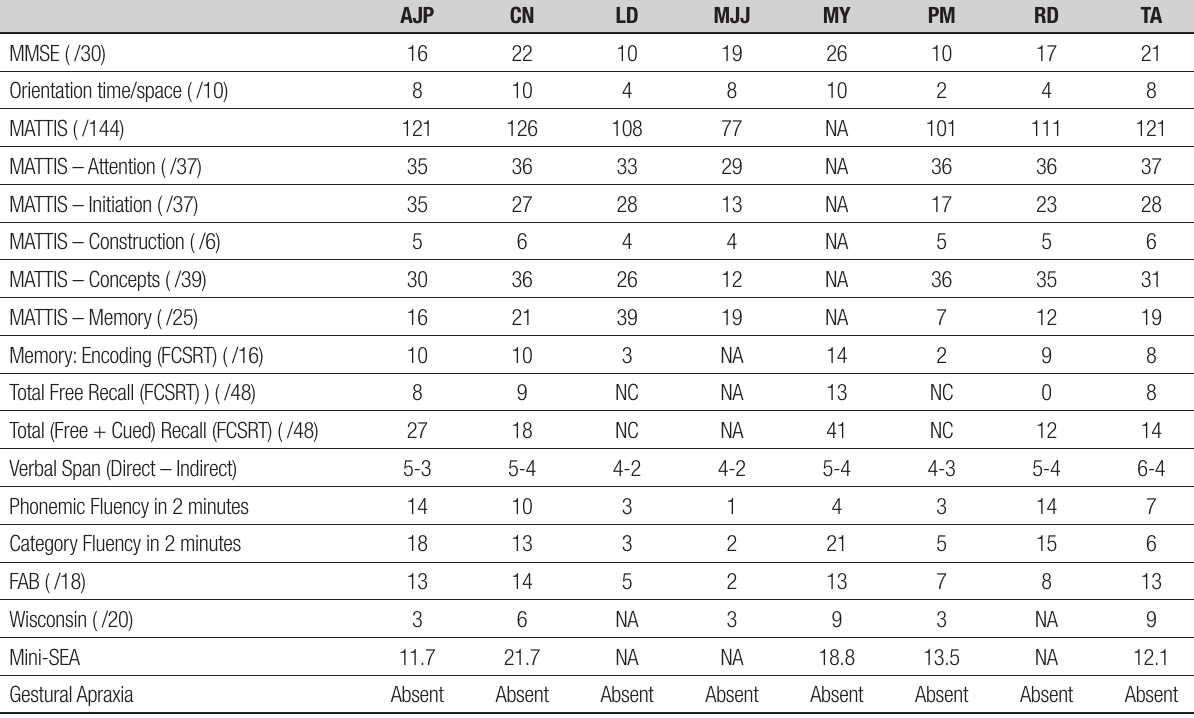
Table 2. Neuropsychological data for each